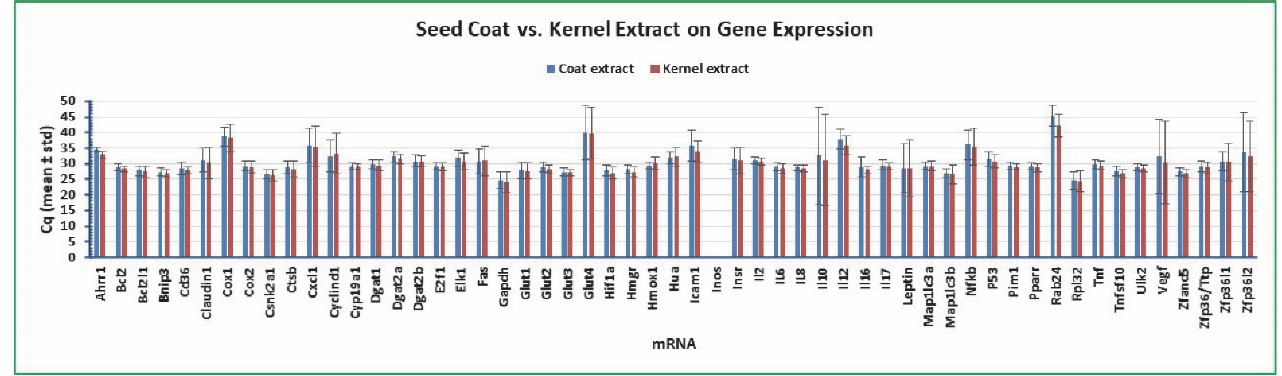
Figure 6. Variation of gene expression between cottonseed coat and kernel extract treatment. The cancer cells were treated with multiple concentrations of cottonseed extracts (0, 5, 10, 20, 30, 40, 50, and 100 µg/mL) for 8 h. Total mRNAs were extracted from the cells, converted into cDNAs, and the relative abundance was analyzed by SYBR Green qPCR. The Cq values represented the mean and standard deviation of 48 independent samples.